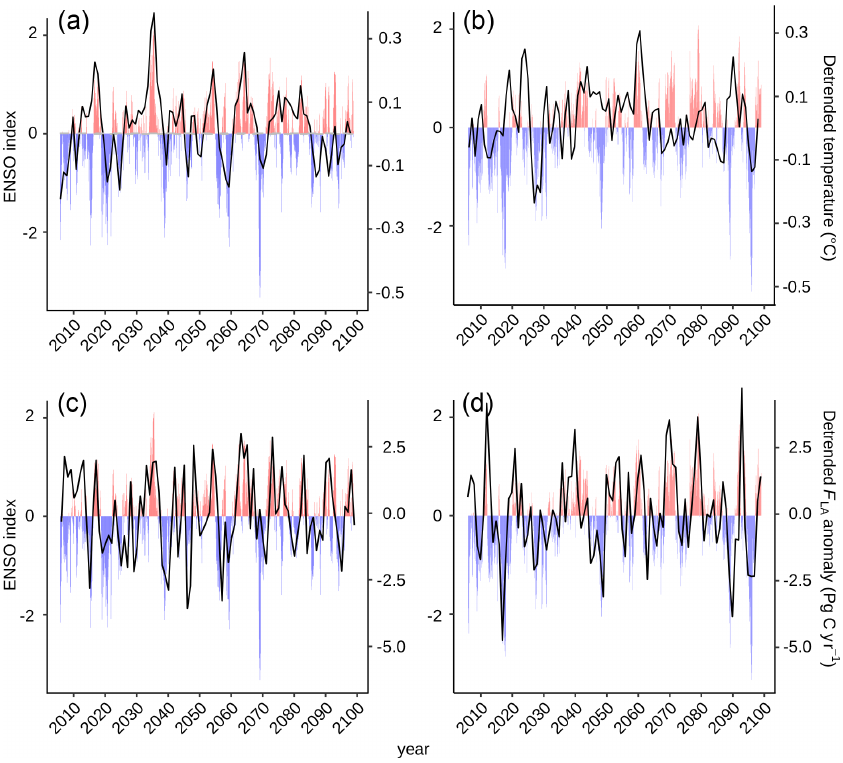
Figure A6. The impact of El Niño–Southern Oscillation (ENSO) on global surface air temperature in the (a) control and (b) restoration simulations, as well as on the land carbon sink ( F LA ) in the (c) control and (d) restoration simulations. Positive ENSO values represent El Niño events (red), while negative values represent La Niña events